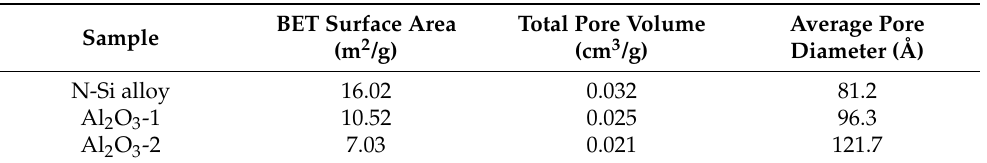
Table 4. BET surface area, total pore volume, and average pore diameter of the N-Si alloy, Al 2 O 3 -1, and Al 2 O 3 -2 powders.